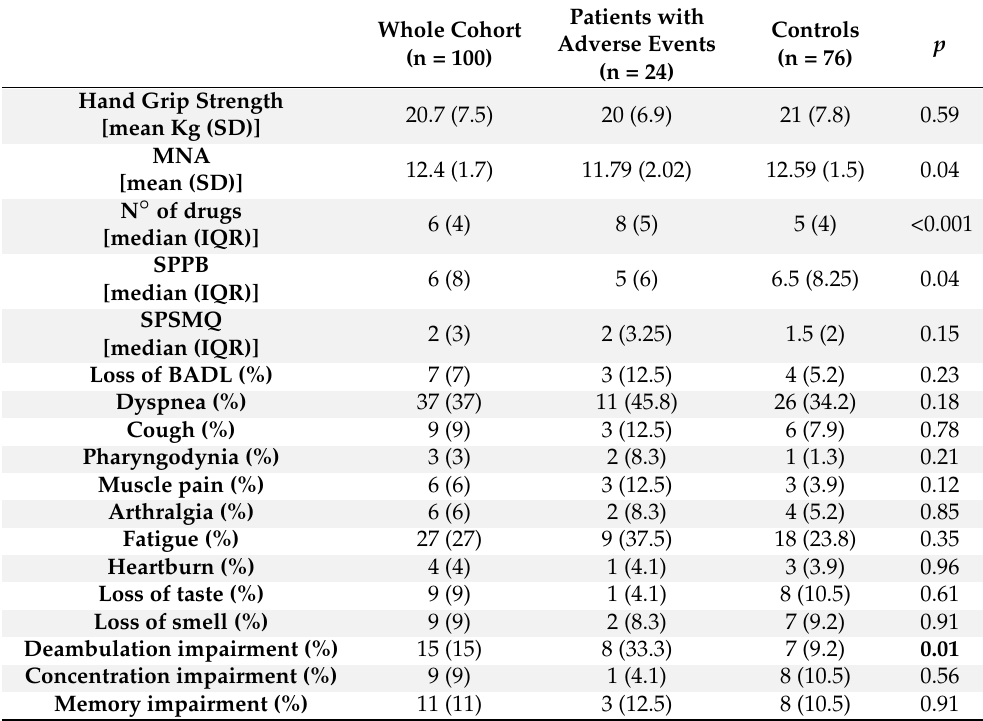
Table 3. Comprehensive Geriatric Assessment and COVID-19 related symptoms at 6-month